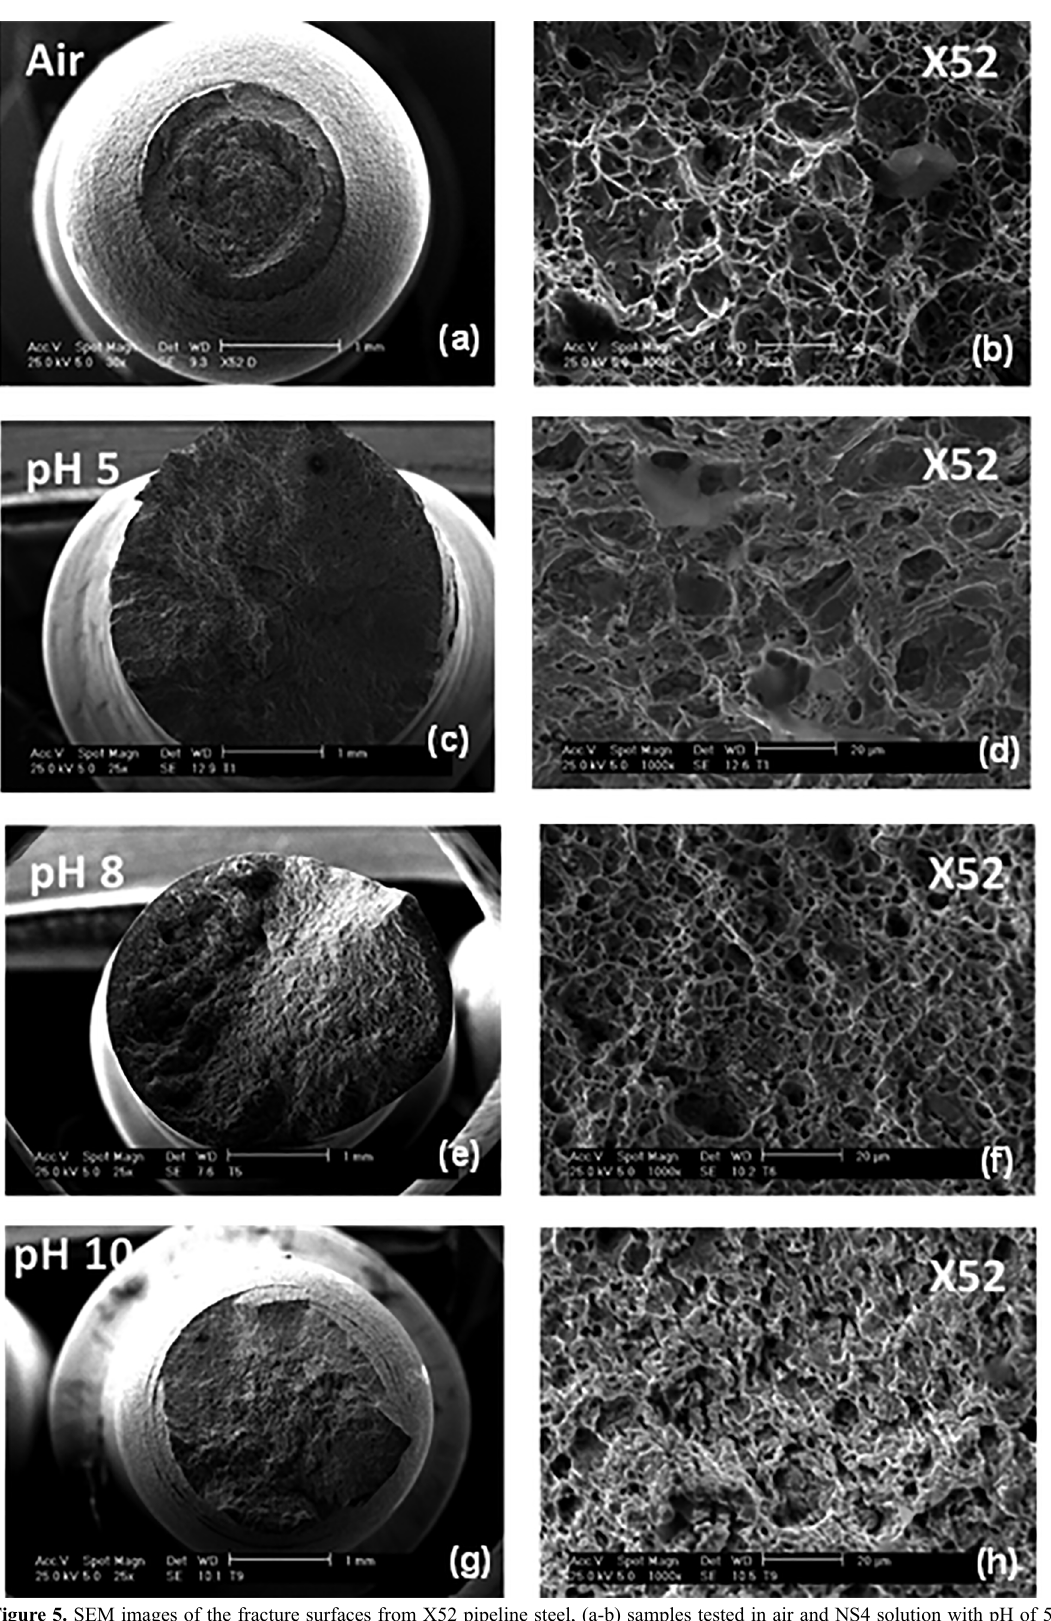
Figure 5. SEM images of the fracture surfaces from X52 pipeline steel, (a-b) samples tested in air and NS4 solution with pH of 5 (c-d), pH 8 (e-f) and pH 10